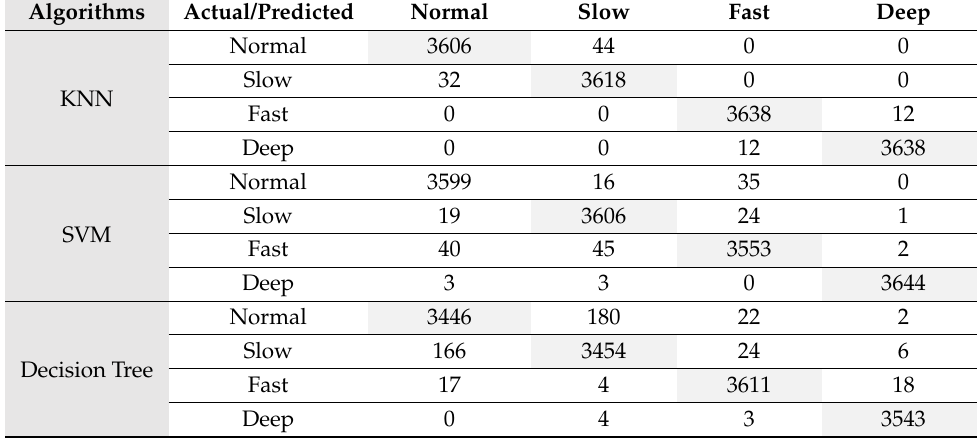
Table 6. Confusion matrix of human breathing experiments